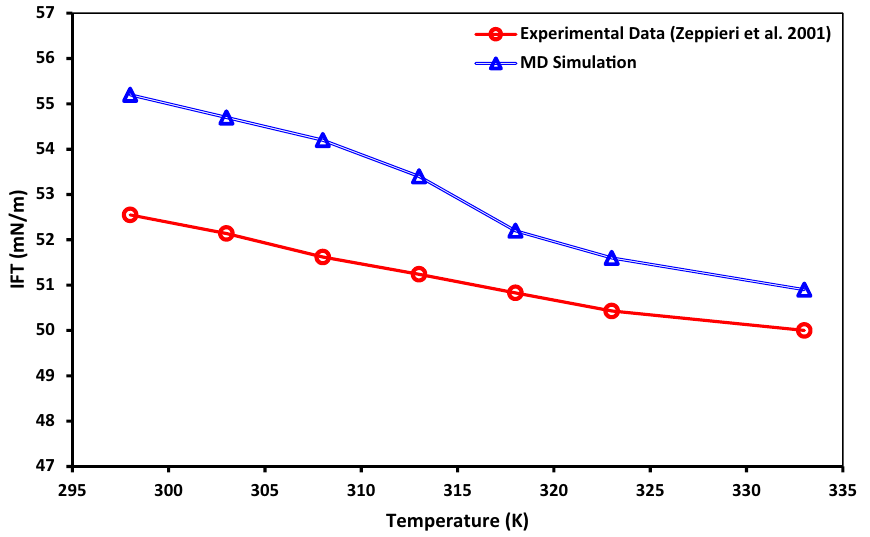
Figure 21. Comparison between IFT gained from experimental 136 and MD simulation for the water–dodecane system at different